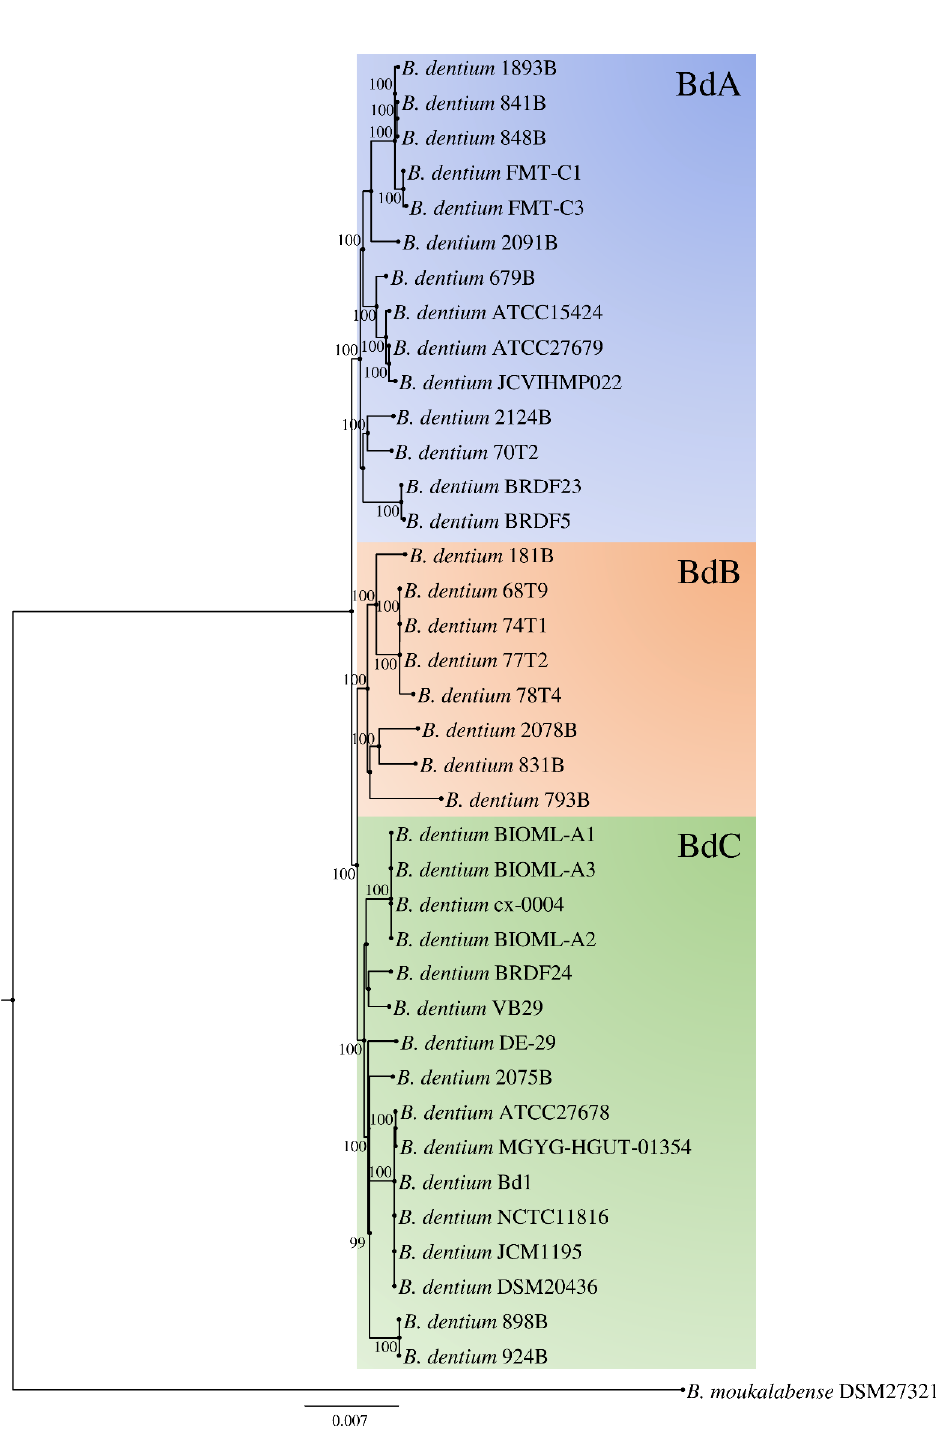
Figure 2. Phylogenetic tree of the B. dentium species. The proteomic tree is based on a concatenation of 1140 core genes identified in the pangenome analysis of 38 B. dentium strains. Phylogenetic groups are highlighted in different colors. The tree was constructed by the neighbor-joining method, and the genome sequence of Bifidobacterium moukalabense DSM 27321 was used as an outgroup. Bootstrap percentages above 50 are shown at node points, based on 1000 replicates.